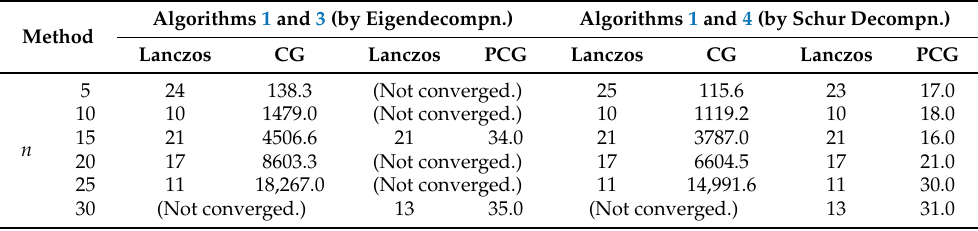
Table A4. Number of iterations of the Lanczos method and the average of numbers of iterations of the CG/PCG method in the case of the median of singular value of marginally symmetric matrix T with a = c = 1 and b = 0.2 in (9) for the shift (A1). Algorithms 1 and 3 (by Method